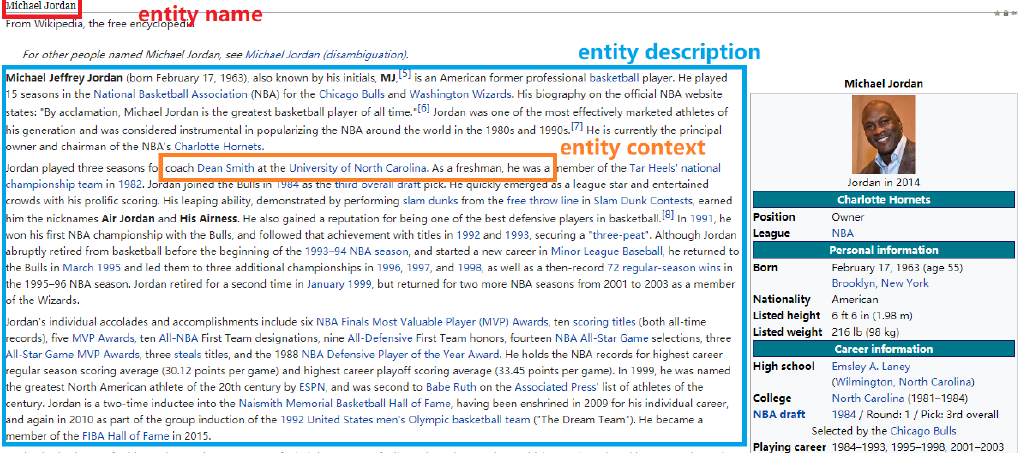
Figure 1. In Wikipedia, each entity has a canonical page and this is the canonical page for the entity “ Michael Jordan ”. The description for the entity “ Michael Jordan ” consists of the words in the blue box. There are many hyperlinks in the page and the words around the hyperlink form the entity context for the corresponding entity. For example, the context for the entity “ North Carolina Tar Heels men’s basketball ” consists of the words in the orange